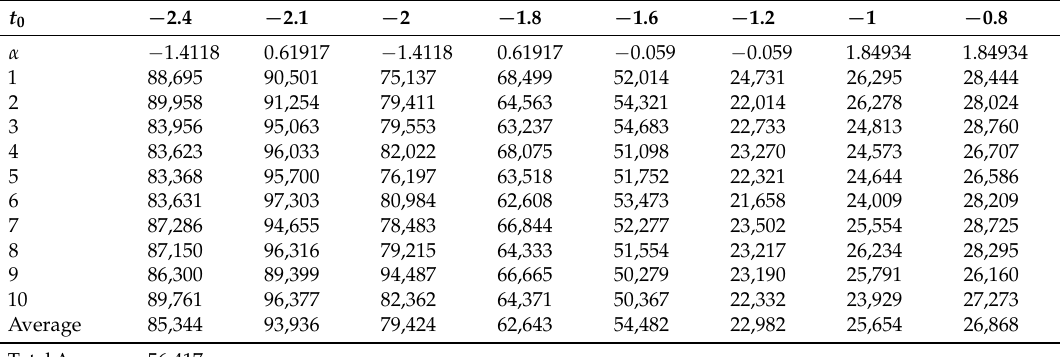
Table 3. Running time for different initial values of Example 2 by our method with test point p = (1.0, 3.0, 5.0).